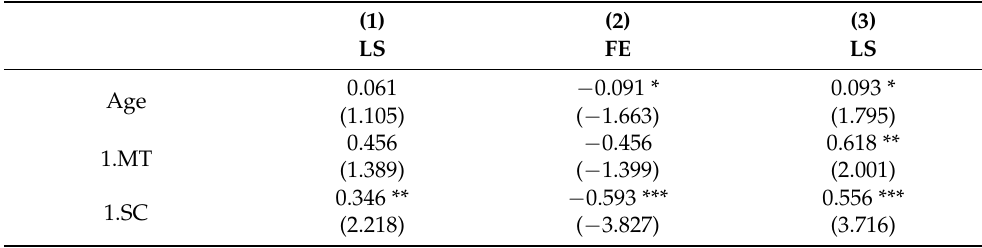
Table 7. The Mediating Effect of Farming expectations on the Impact of Cultivated Land Location on Life